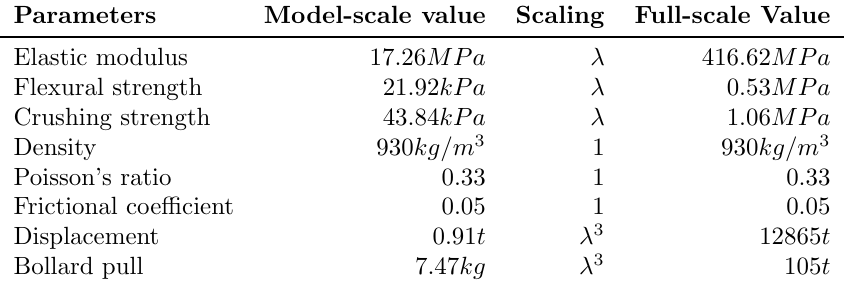
Table 3: Scaling of the input parameters for the full-scale simulation.